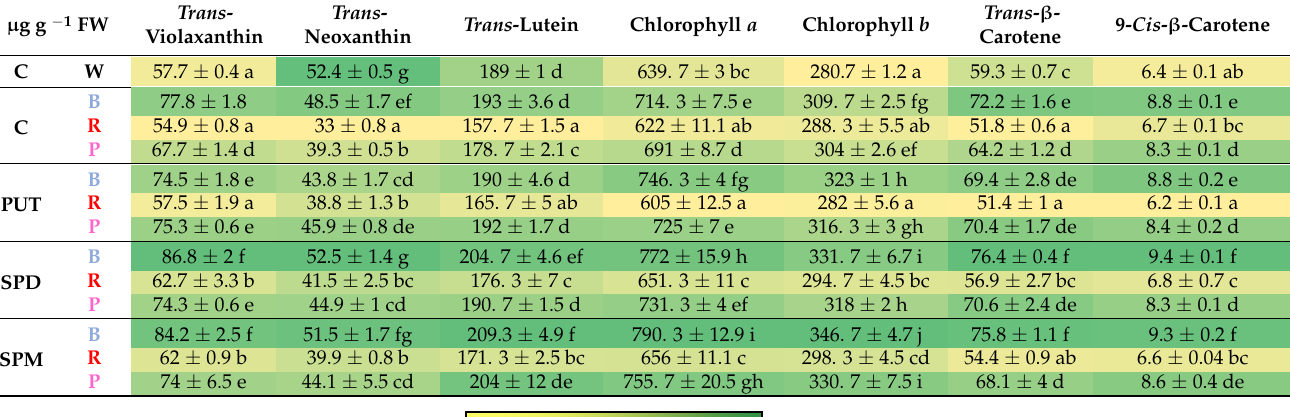
Table 1. Color-map comparison of the pigment contents ( trans -violaxanthin, trans -neoxanthin, trans -lutein, chlorophyll a, chlorophyll b, trans - β -carotene, and 9- cis - β -carotene) of leaves of plants grown under different light regimes (white light: W, blue light: B, red + far-red: R and the combination of blue and red + far-red, pink: P) treated with or without polyamines (control: C, putrescine: PUT, spermidine: SPD and spermine: SPM). Values are means ± SD of 3 measurements per treatment. Different letters indicate statistically significant differences at p < 0.05 level, using Duncan’s post hoc test.